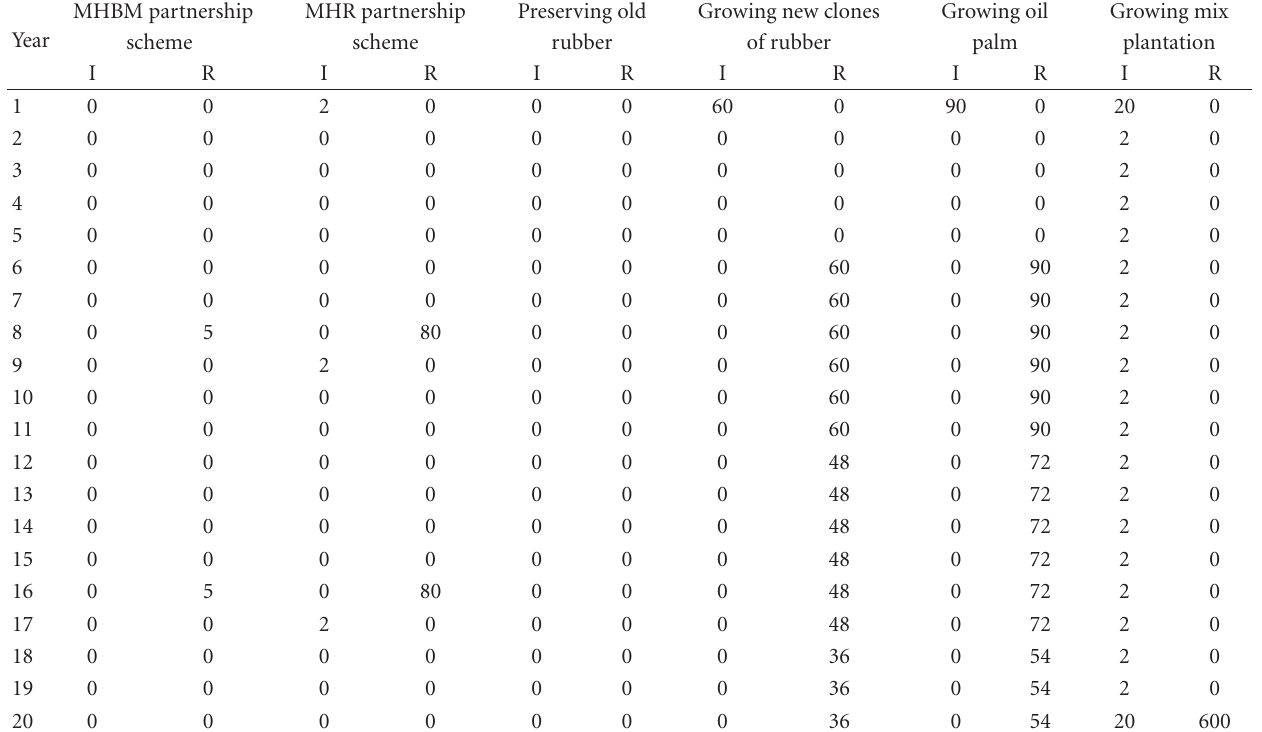
Table 1: Investment (I) and return (R) in millions